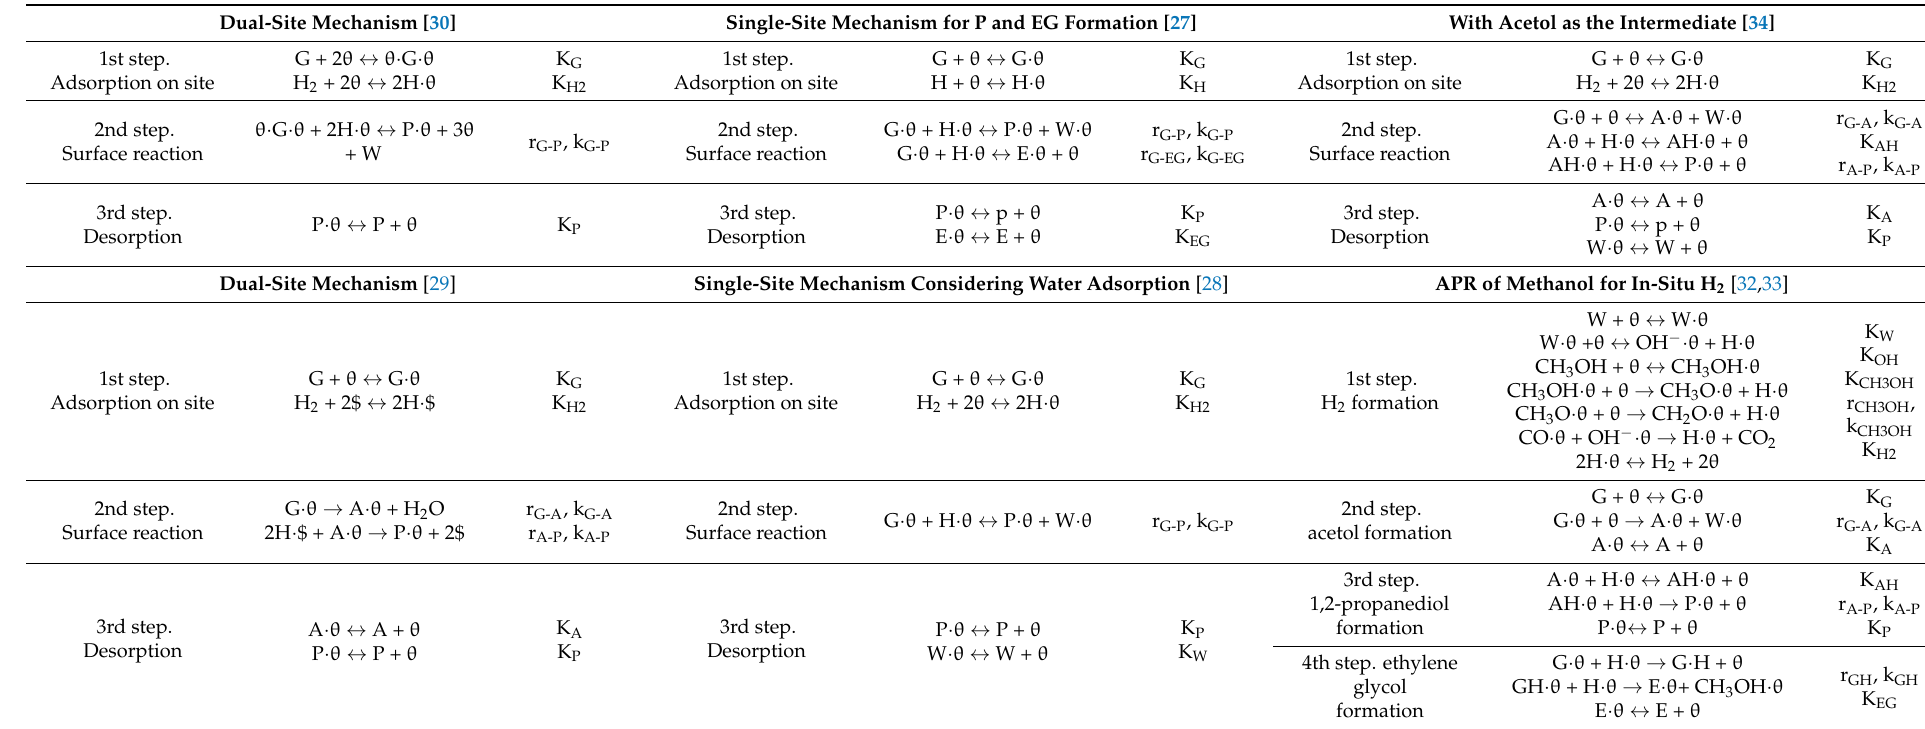
Table 4. Mechanistic description for glycerol conversion